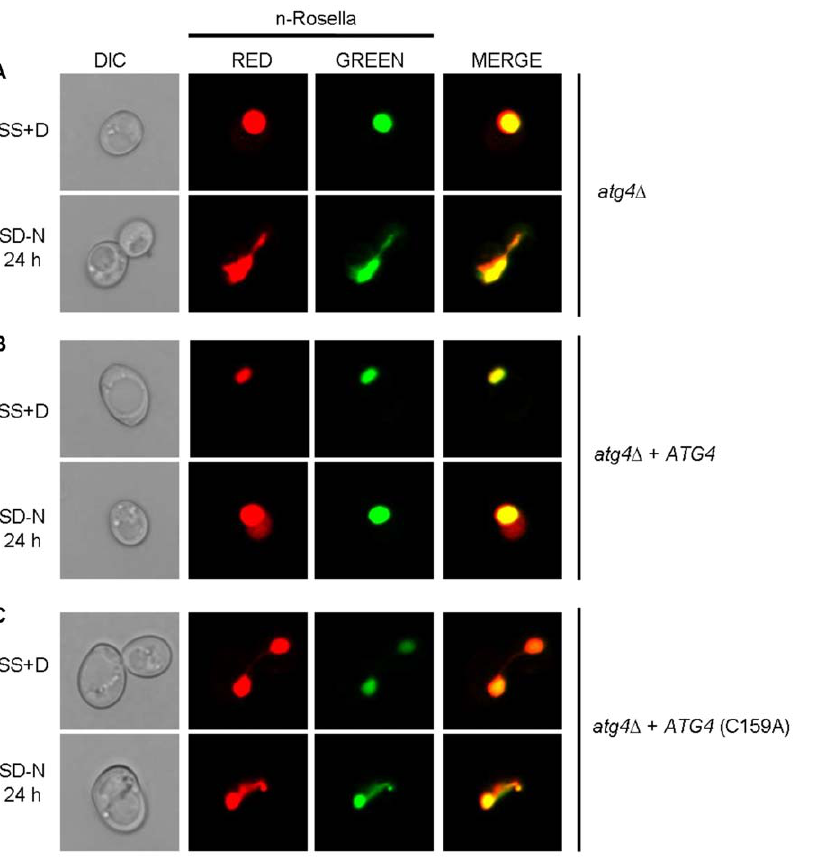
Figure 8. The absence of a functional ATG4 gene product abrogates the delivery of n-Rosella to the vacuole and influences nuclear morphology. atg4 D ( A ), atg4 D + ATG4 ( B ), and atg4 D + Atg4C159A ( C ) cells expressing n-Rosella were imaged under growing (SS + D) and nitrogen starvation (SD 2 N) conditions (24 hours after commencement of nitrogen starvation).